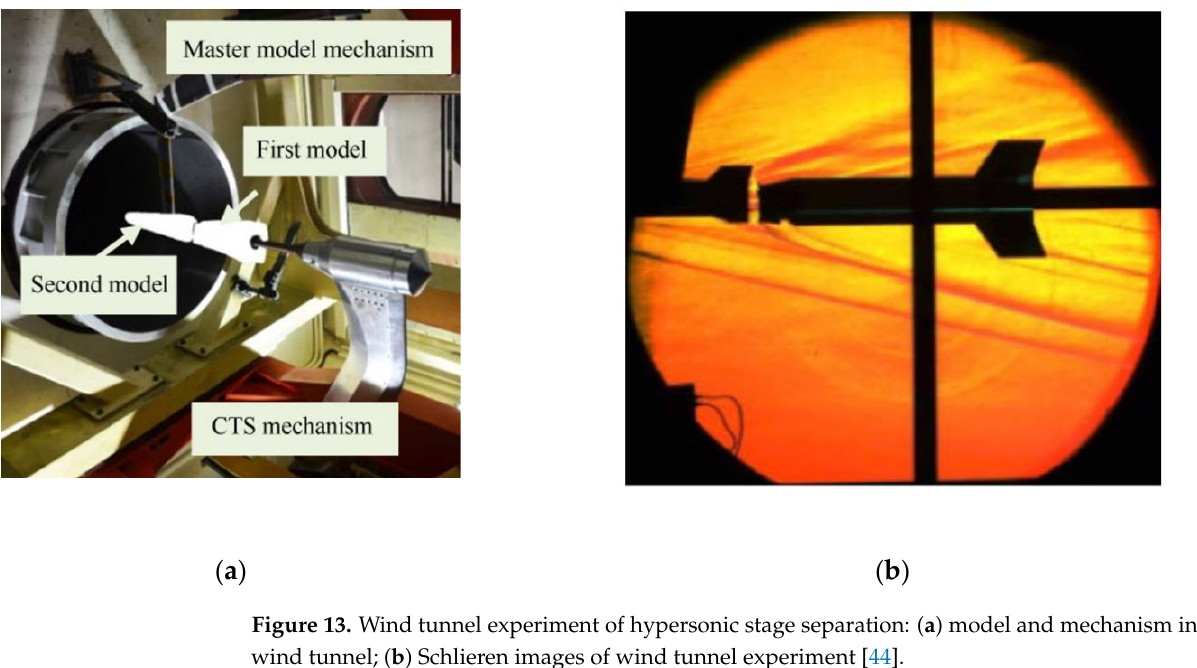
Table 5. Free-stream flow conditions of stage separation.